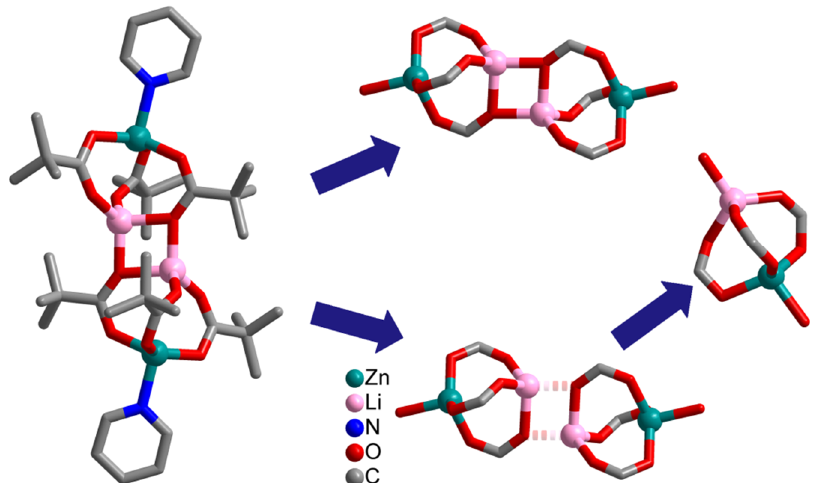
Figure 1. Structure of the presynthesized pivalate complex [Li 2 Zn 2 (piv) 6 (py) 2 ] and obtained heterometallic nodes.